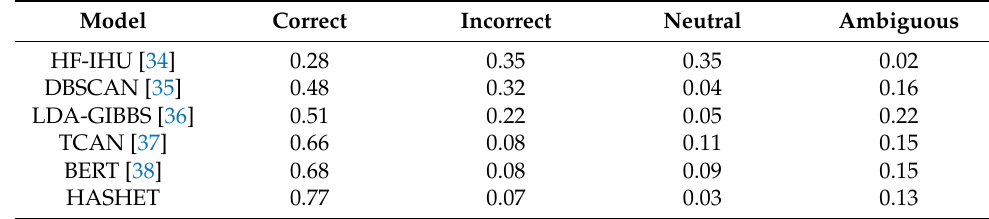
Table 3. Results comparison with state-of-the-art